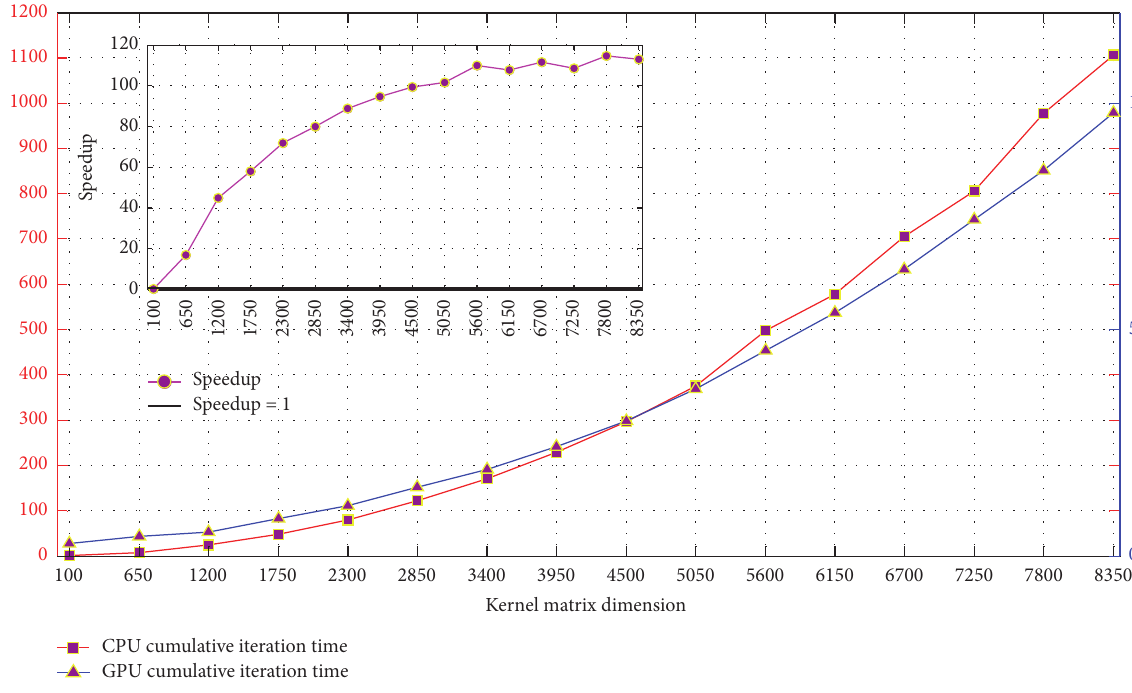
Figure 2: Elapsed time and speedup for RBF parameter computation on GPU and CPU.